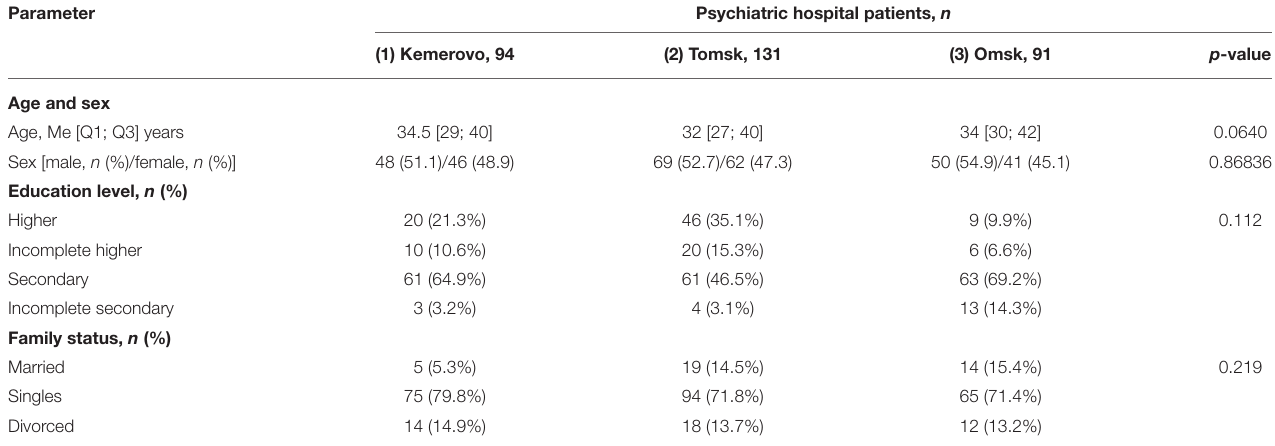
TABLE 1 | Study population